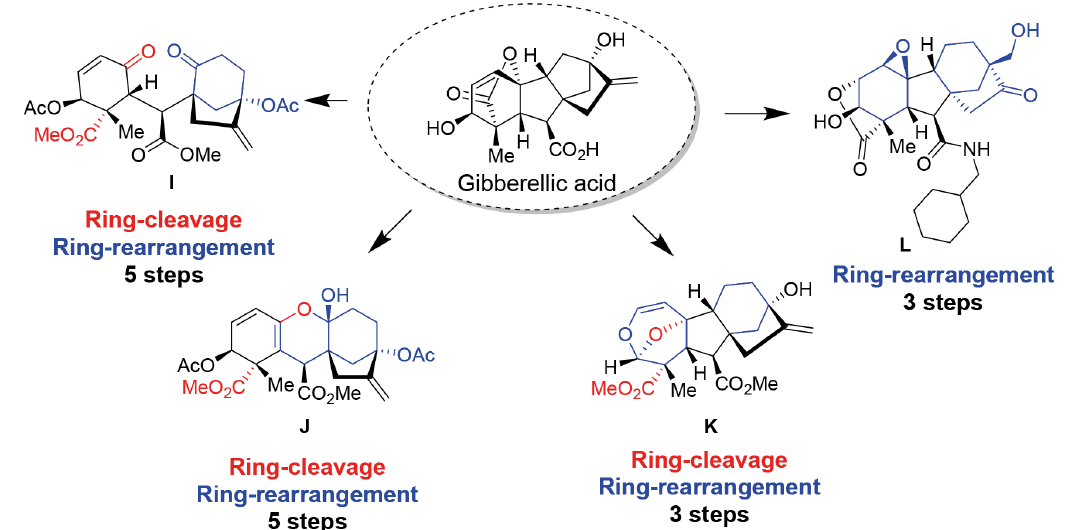
FIGURE 13 - Ring-distortion strategies to access gibberellic-based